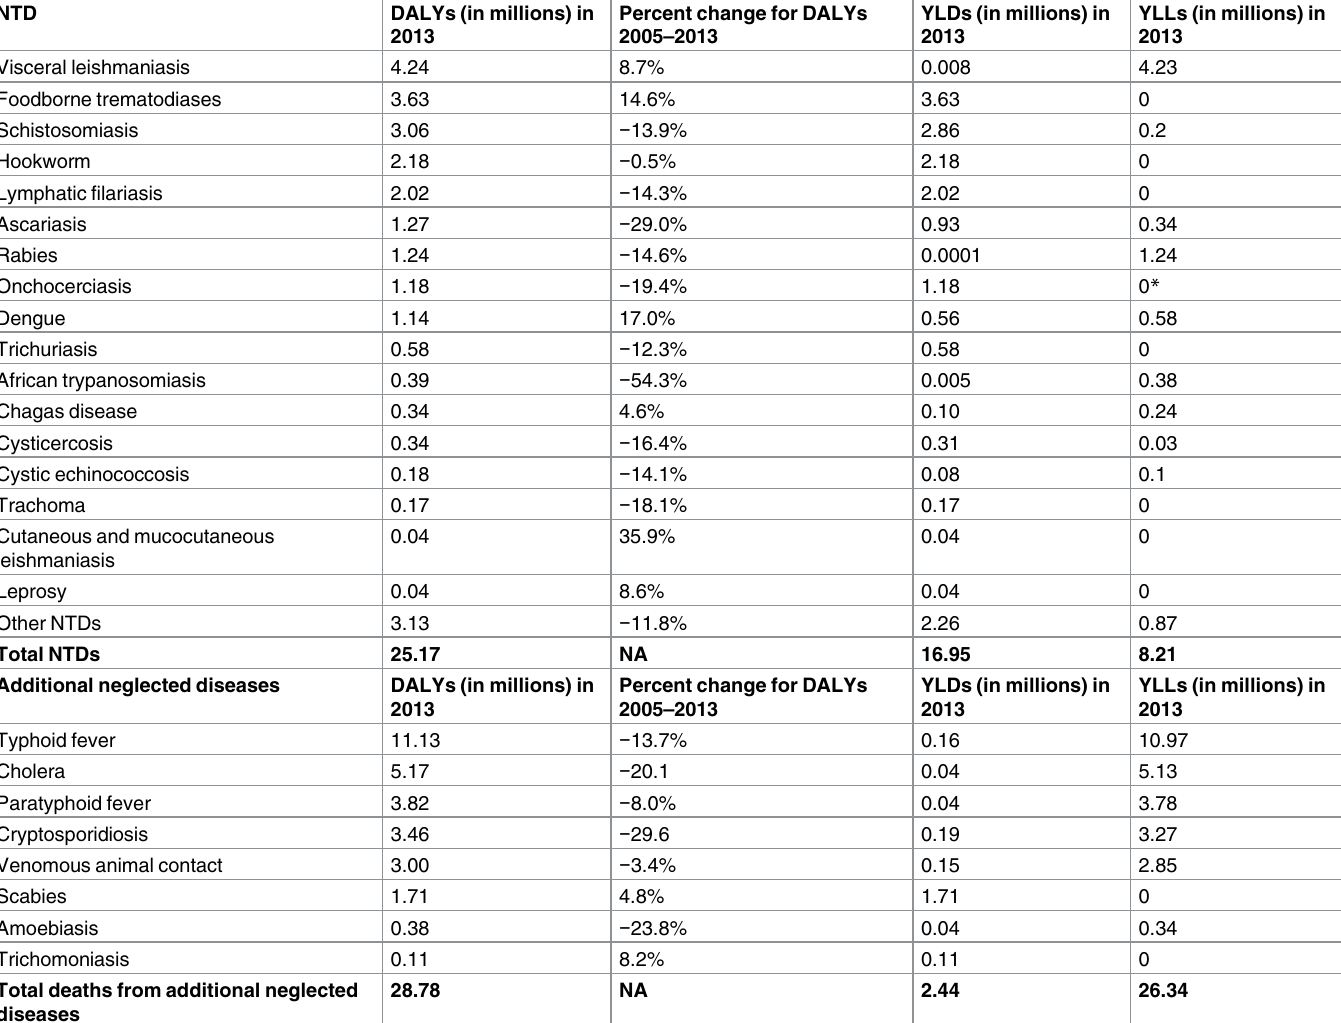
Table 3. Leading causes of disability-adjusted life years(DALYs) resulting from the NTDs according to the Global Burden of DiseasesStudy (GBD) 2013 with attributing yearslived with disability (YLDs) and yearsof life lost (YLLs)